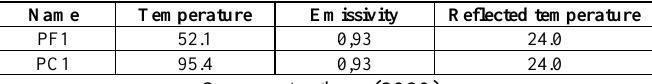
Figure 6: Fractures in the glass covert of the PV module. Table 5: Markers referring to the analysis of Figure 6.